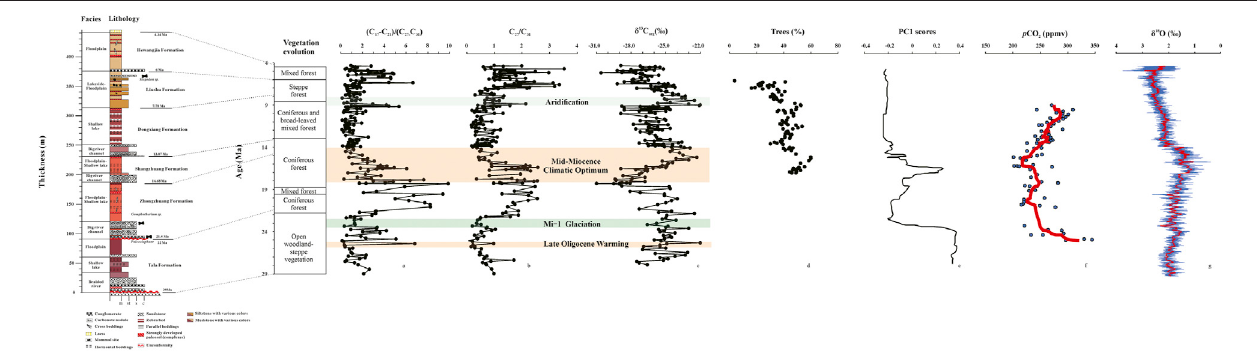
FIGURE3| ComparisonofdifferentproxiesfromtheMaogousedimentswithotherindicators,includingtheratioof(C 17 -C 21 )/(C 27 -C 31 )(a),theC 27 /C 31 ratio(b),the δ 13 C org valuesoforganic matterfrom Maogousediments(c), thepercentage oftree pollenfrom theYanwan section, TianshuiBasin(d)(Hui etal., 2011),thePC1 scores from the Jingou River section in northern Tian Shan, with higher PC1 scores denoting wetter conditions (e) (Tang et al., 2011), the atmospheric CO2 concentrations reconstructedbasedonthecarbonisotopicanalysesofdiunsaturatedalkenonesandplanktonicforaminifer(f)(Paganietal.,1999),andthecompiled δ 18 Orecords (g) (Westerhold et al., 2020). Further comparison containing the sedimentary facies, lithology, age-depth model modi fi ed from He et al. (2020), and vegetation evolution based on pollen records from Ma et al. (1998).